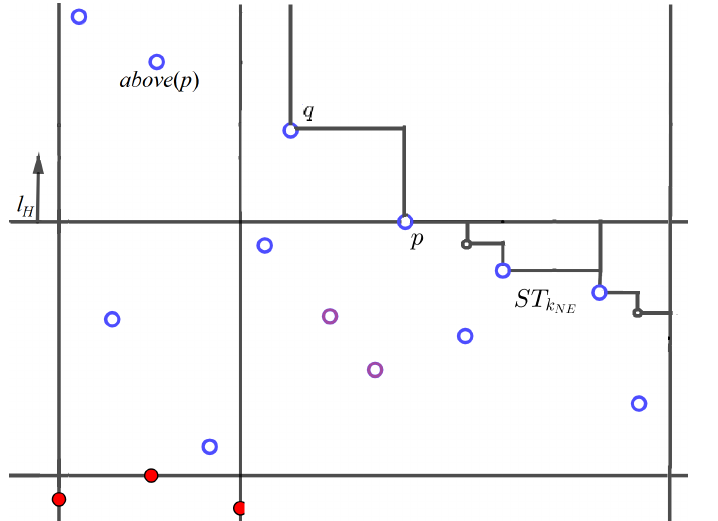
Figure 5. Case 2. p ∈ B NE , q ∈ B NE , and q is to the left of p . The purple empty dots denote U ( q , p ) .